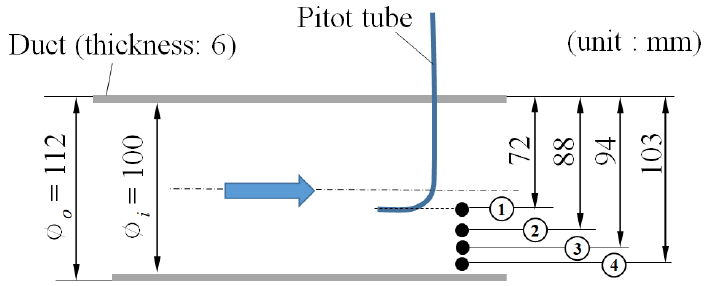
Figure 4. Velocity measuring positions (black dot positions) by a Pitot tube (blue arrow represents flow direction).